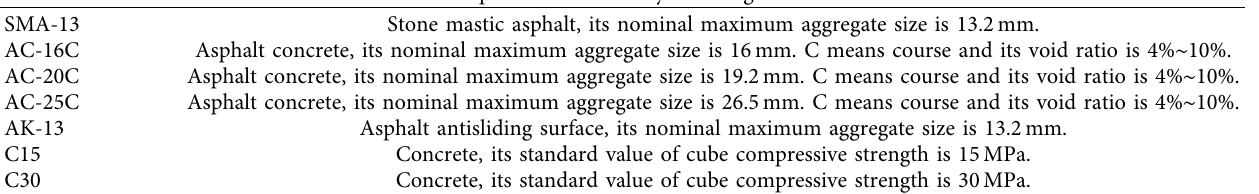
Figure 9: The original pavement structures in the entrance and exit sections of the Yangkou tunnel (Str-2). Table 2. Explaination of acronyms in Figures 8 and